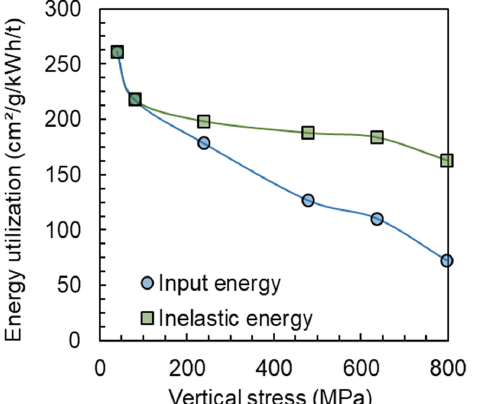
Figure 12. Comparison of energy utilization for different applied vertical stresses for the Itabira sample for the narrow size range of 150–125 µm, considering both the input and the inelastic energy.